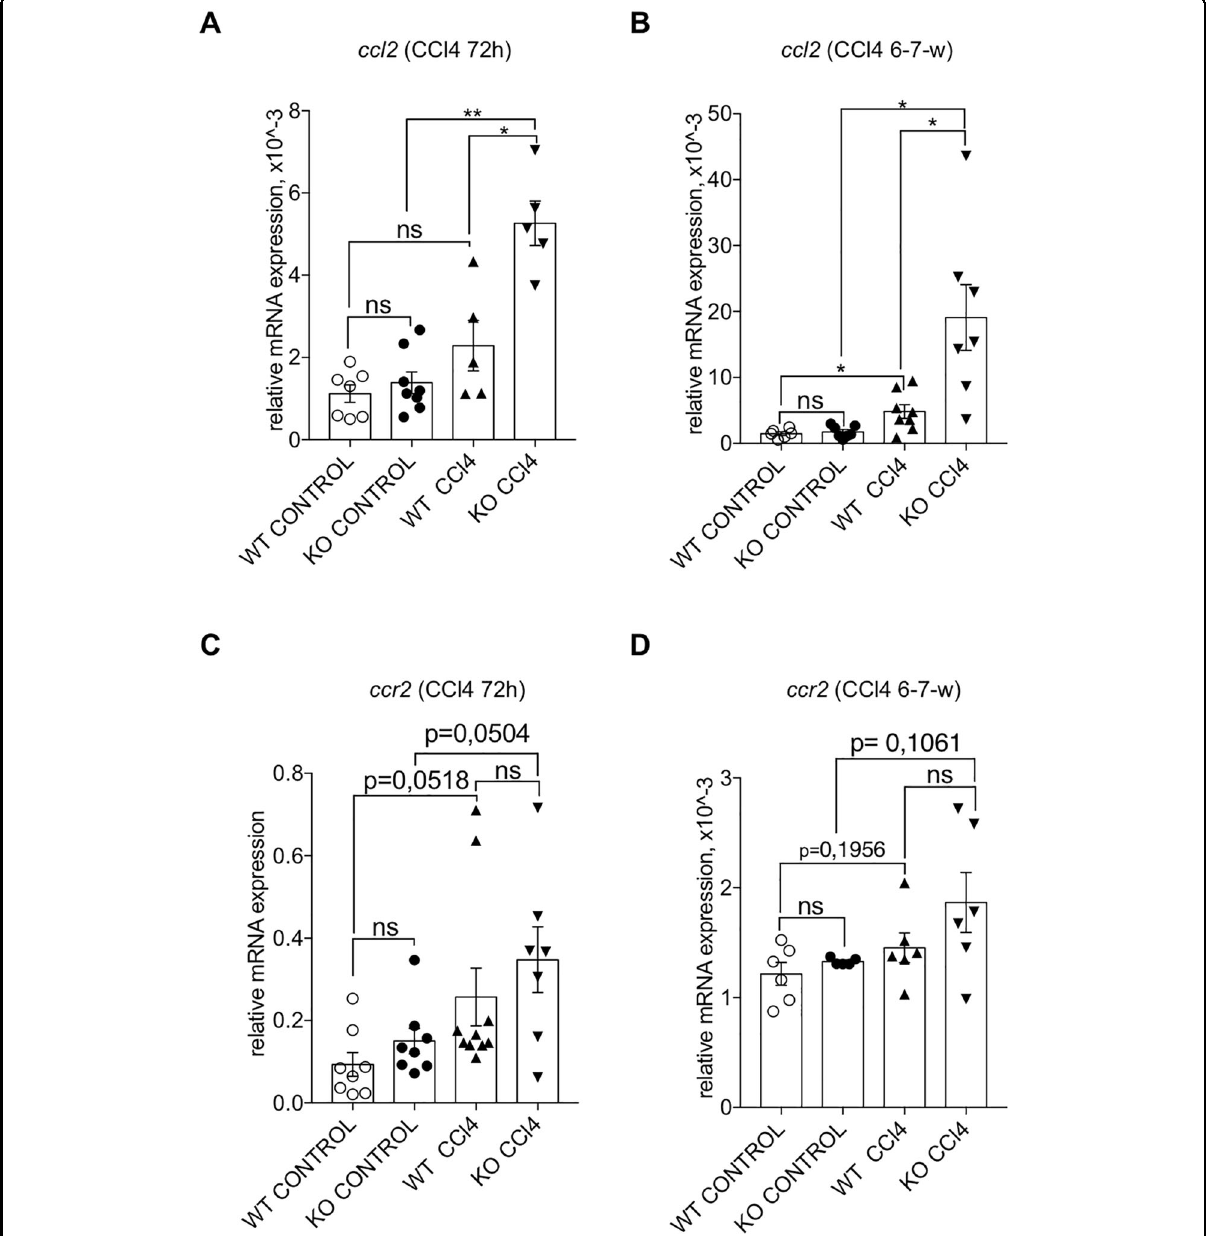
Fig. 5 Lack of GILZ results in increased Ccl2 mRNA expression in the liver following CCl 4 treatment. A , B qPCR analysis of Ccl2 mRNA expression in the livers of 4-month-old WT and GILZ KO mice that had been treated for 72 h ( A ) or 6 – 7 weeks ( B ) with oil (control) or CCl 4 . C , D qPCR analysis of Ccr2 mRNA expression in the livers of 4-month-old WT and GILZ KO mice that had been treated for 72 h ( C ) or 6 – 7 weeks ( D ) with oil (control) or CCl 4 . All data are presented relative to Actb mRNA expression. Each dot represents an individual mouse; scale bars indicate the mean. Results are presented as the means ± SEM. Data were pooled from three ( A – C ) or two ( B – D ) independent experiments (* p < 0.05, ** p < 0.005, ns not signi fi